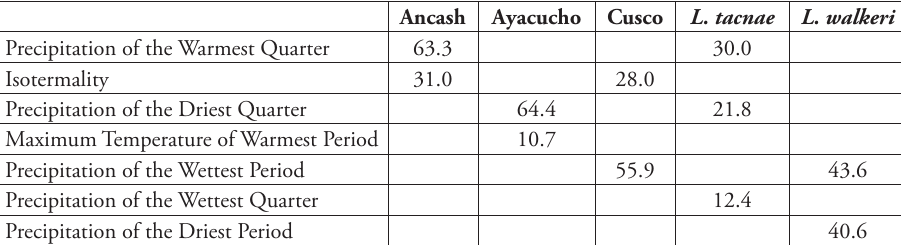
table 5. Percentage contributions of most important bioclimatic variables to the ecological niche en- velopes for all population samples of three species of Liolaemus described herein, plus L. tacnae and L. walkeri